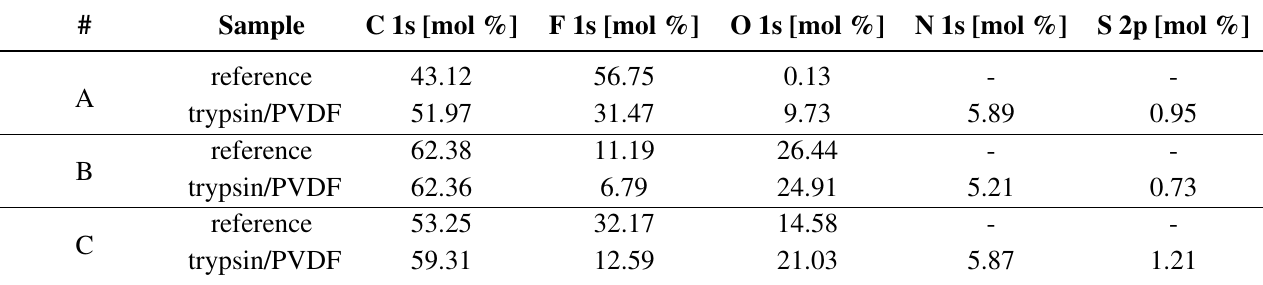
Table 2. XPS (X-ray photoelectron spectroscopy) data of the unmodified and modified PVDF